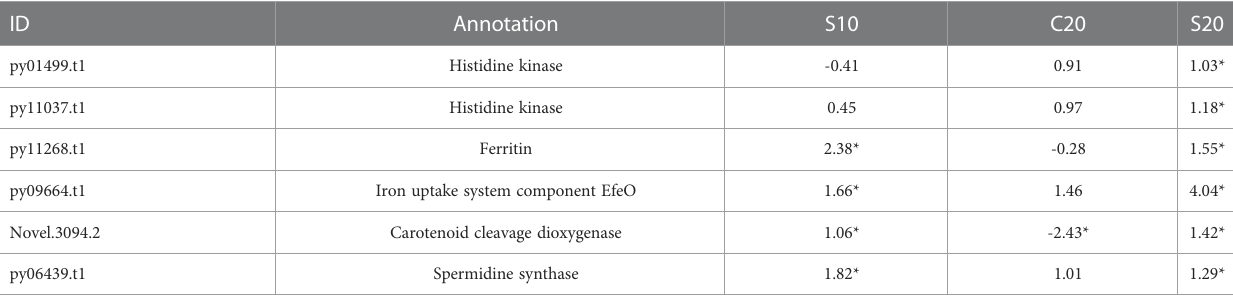
TABLE 2 Expression (Log 2 Foldchange value) of key genes for heat-tolerance under different conditions.